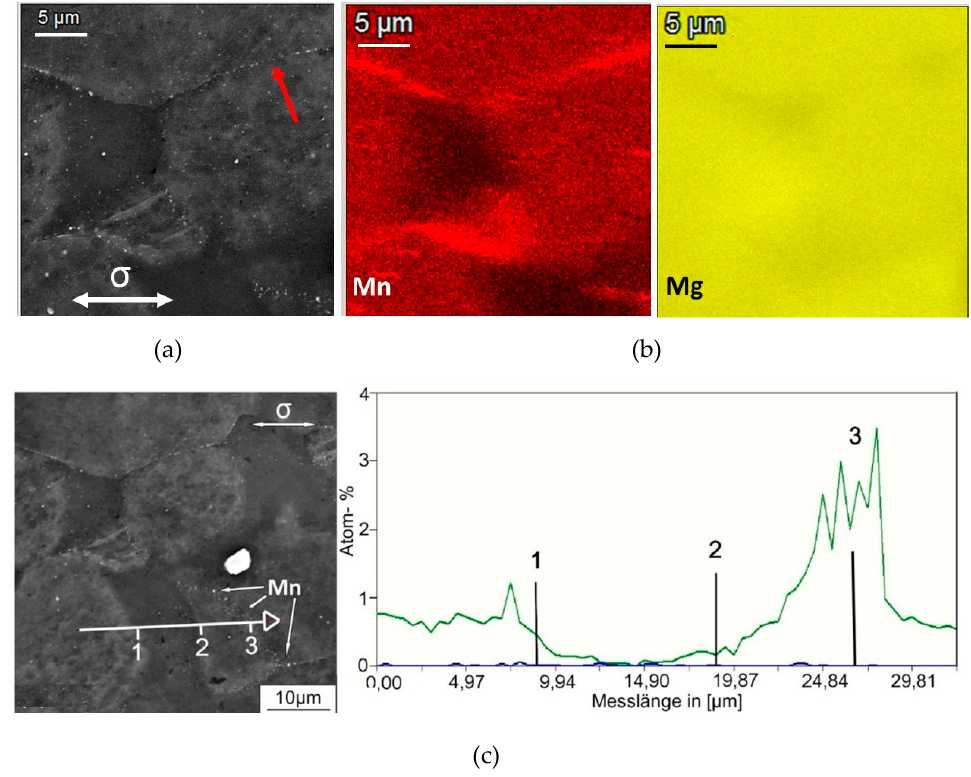
Figure 7. SEM, denuded zone, ( a ) SE image, ( b ) EDX-mapping of Mn + Mg, ( c ) EDS-line scan. Additionally to the grain morphology and the denuded zones, the creep voids are characterized by shape and distribution. It has to be noticed, detailed analysis of the porosity fraction is not the subject of this work. The creep voids form preferentially at grain boundaries oriented perpendicular to the loading direction (Figure 6). Figure 8a–c show the longitudinal sections of a standard creep specimen at σ = 20 MPa. Next to the fracture surface a higher porosity is observed (Figure 8a). As already visually is apparent, with increasing distance from the fracture surface, a gradual decrease in void number and size occurs (Figure 8a–c). This behavior is detected in all measured specimens and thus appears to be independent of load. The shape of individual voids is predominantly elliptical, with the longitudinal axis oriented perpendicular to the loading direction. The same behavior is observed in the miniature creep samples, too (Figure